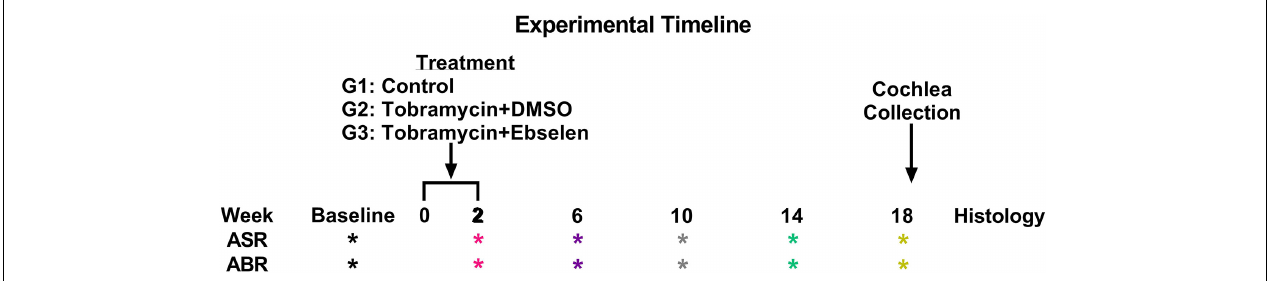
FIGURE 1 | Experimental timeline. ASR and ABR tests (* symbol) are color coded to specific weeks the tests occurred after the start of treatment. This color code is maintained throughout the manuscript. Tobramycin treatment was carried out from week 0 to 2 for two separate dosing groups. Animals were sacrificed after week 18 tests for cochlear